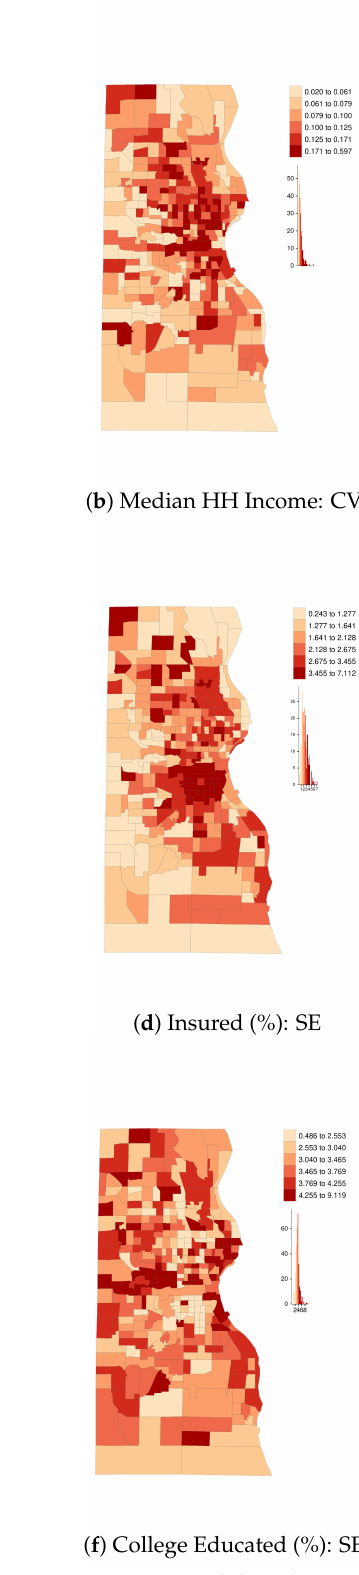
Figure 2. Milwaukee County, Wisconsin census tract-level five-year 2018 ACS estimates and their data quality measure (CV for income, SEs for the others) for select variables. Median HH income is reported in thousands of